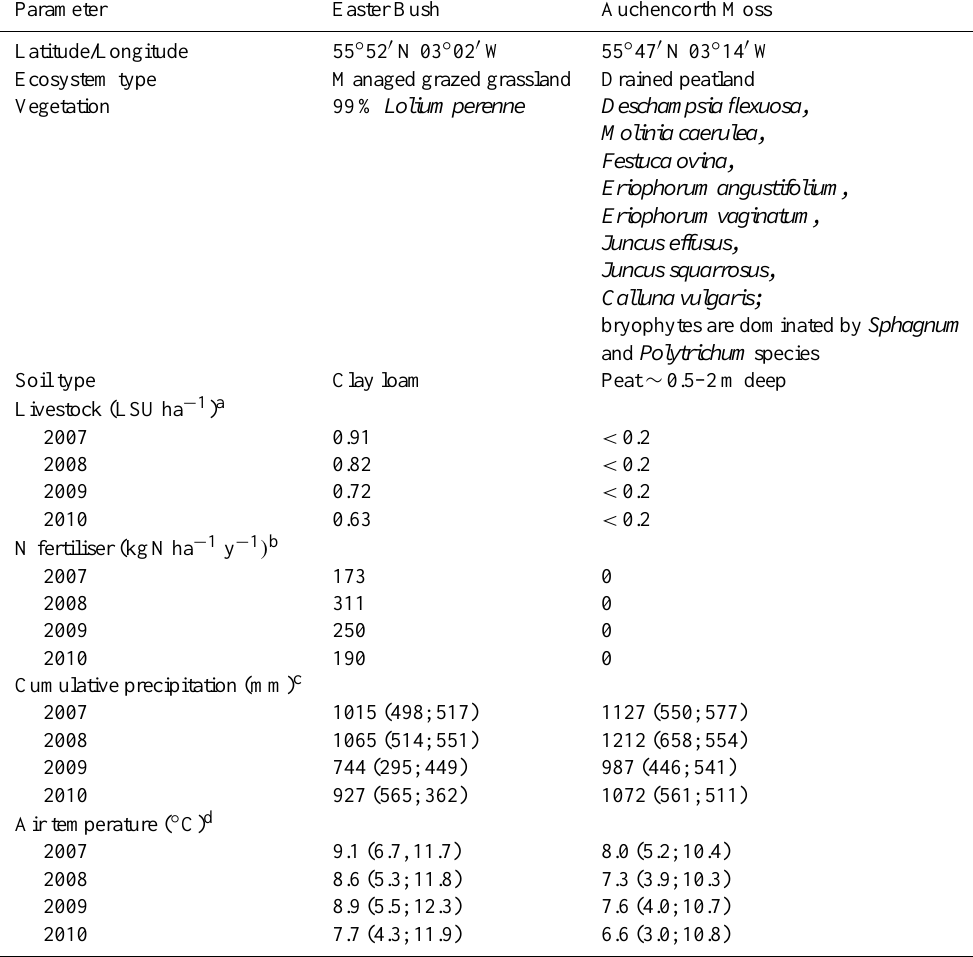
Table 1. Site characteristics and climate data for Auchencorth Moss and Easter Bush.